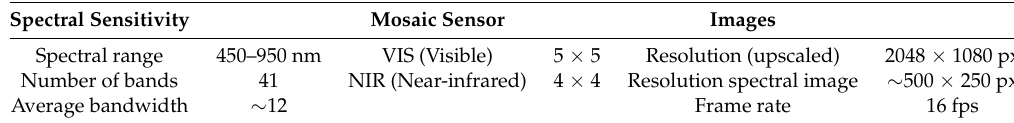
Table 1. Hyperspectral camera characteristics.